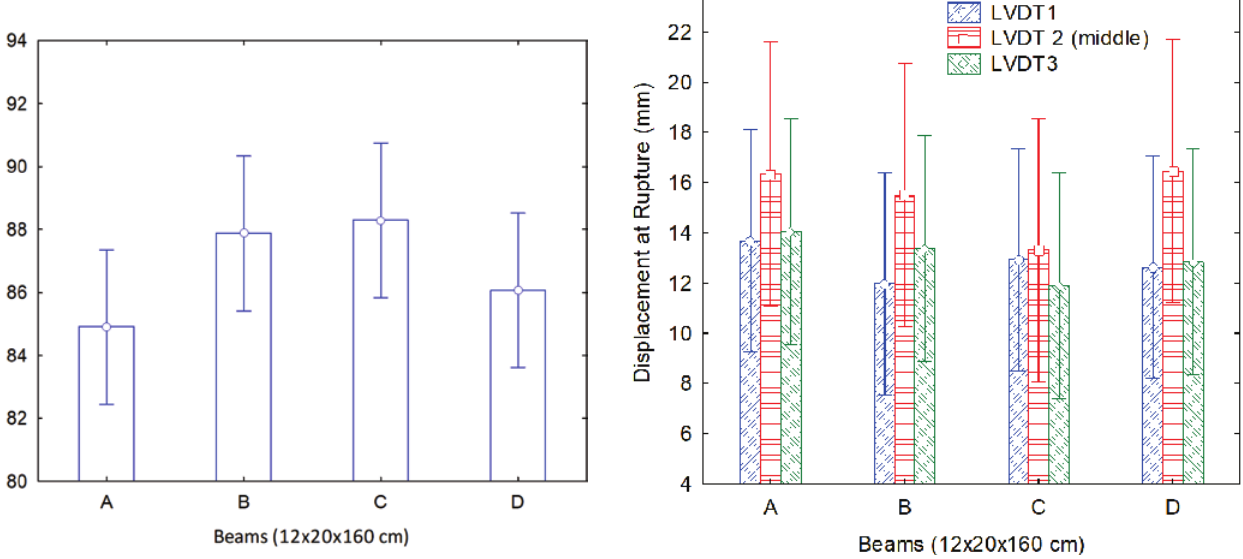
Analysis of the results of displacement at rupture in beams (12 × 20 × 160